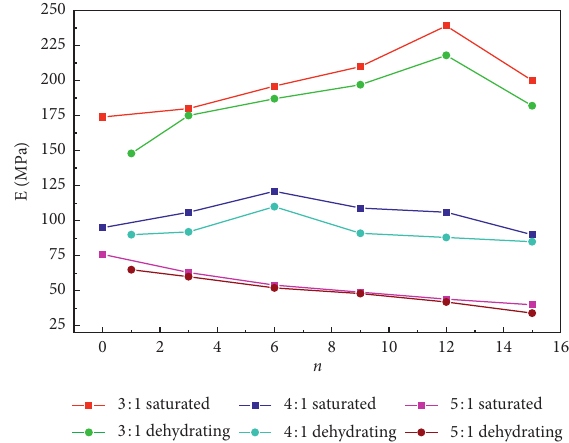
Figure 6: Relationship between elastic modulus and dry-wet cycles.